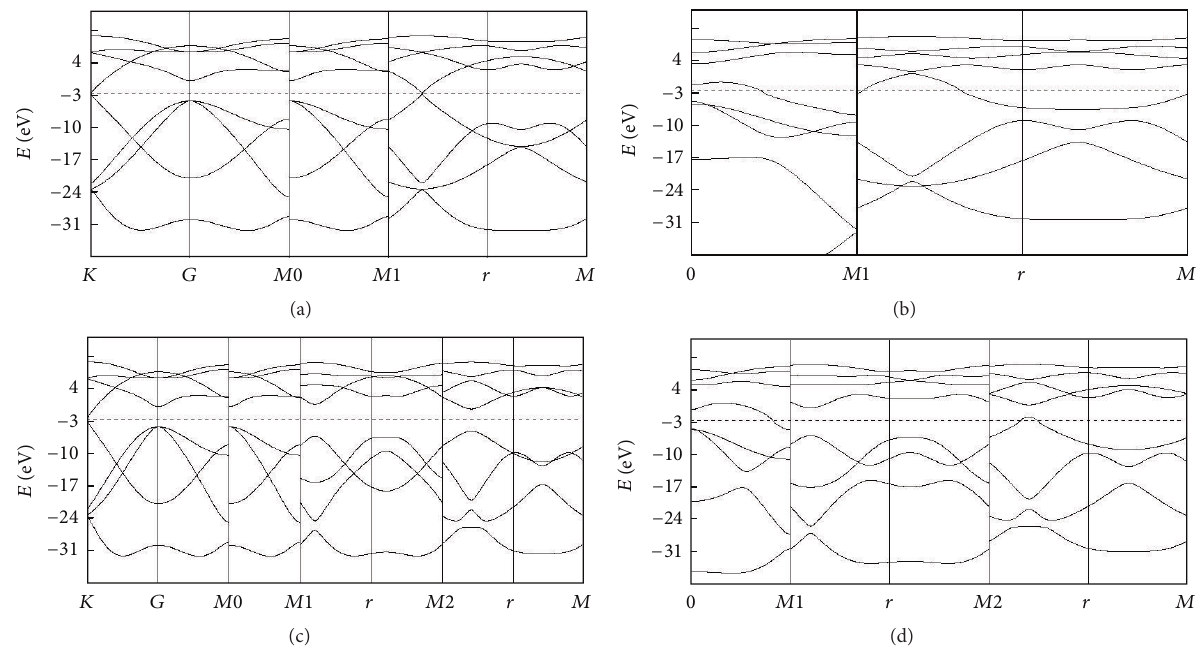
Figure 4: Band structure of ((a), (b)) [(3,0),91], 𝜙 ≈ 3.75 ˚A and ((c), (d)) [(5,0),91], 𝜙 ≈ 6.26 ˚A SWSiNTs. Comparison of band structures calculated by ((a), (c)) zone-folding method and ((b), (d)) calculated directly by helical method of tube formation which account for effect of tube curvature; for details see the